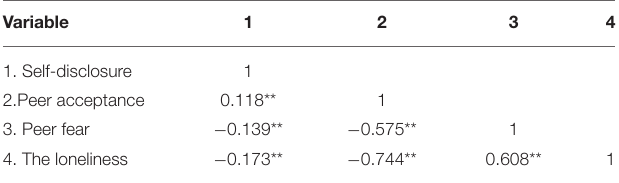
TABLE 1 | Demographics and responses of participants ( N = 830). TABLE 2 | Pearson correlation matrix of variables in Study ( N = 830).